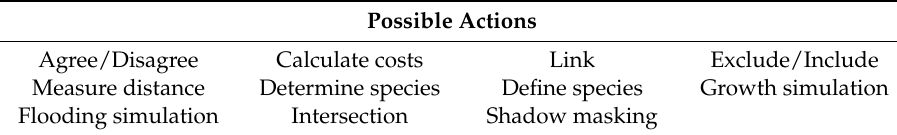
Table 2. Words representing